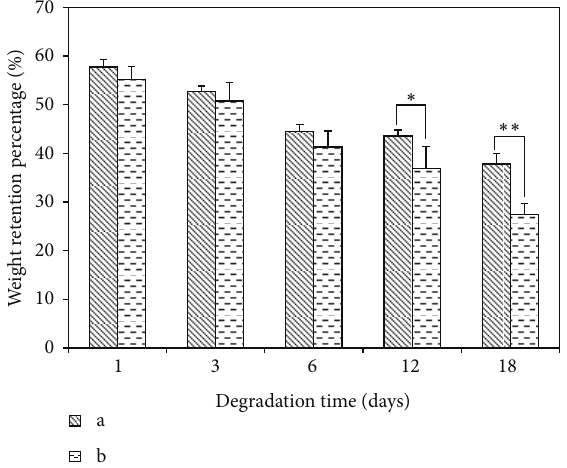
Figure 8: The weight loss of the scaffolds after enzymatic degra- dation for 1, 3, 6, 12, and 18 days (a) unmodified; (b) modified. ∗ 𝑃 < 0.05 , ∗∗ 𝑃 < 0.01